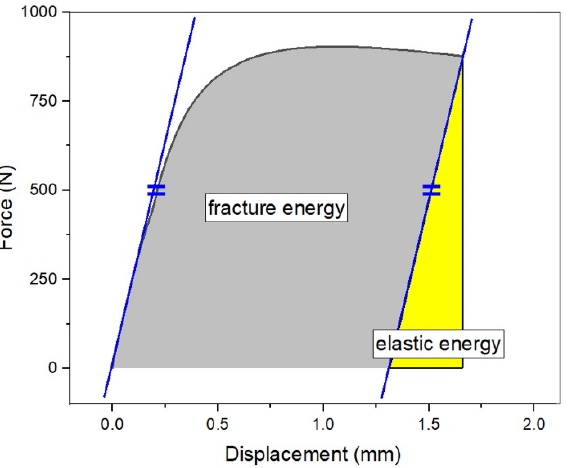
Figure A3. Correction for elastic unloading of the area under the force–displacement curve of tensile tests.